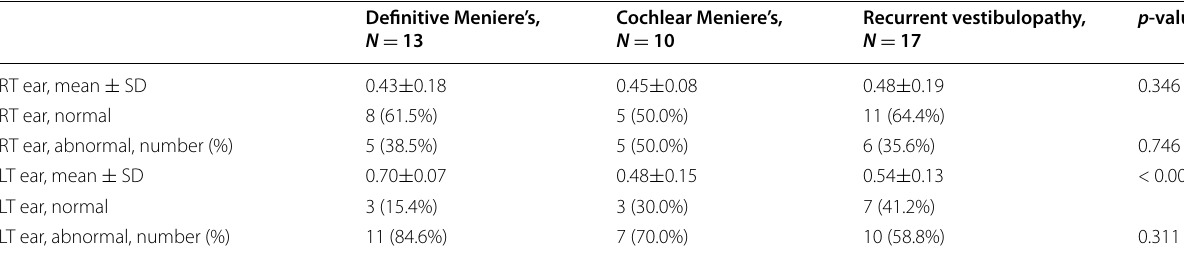
Table 8 Electrocochleography SP/AP ratio in different groups